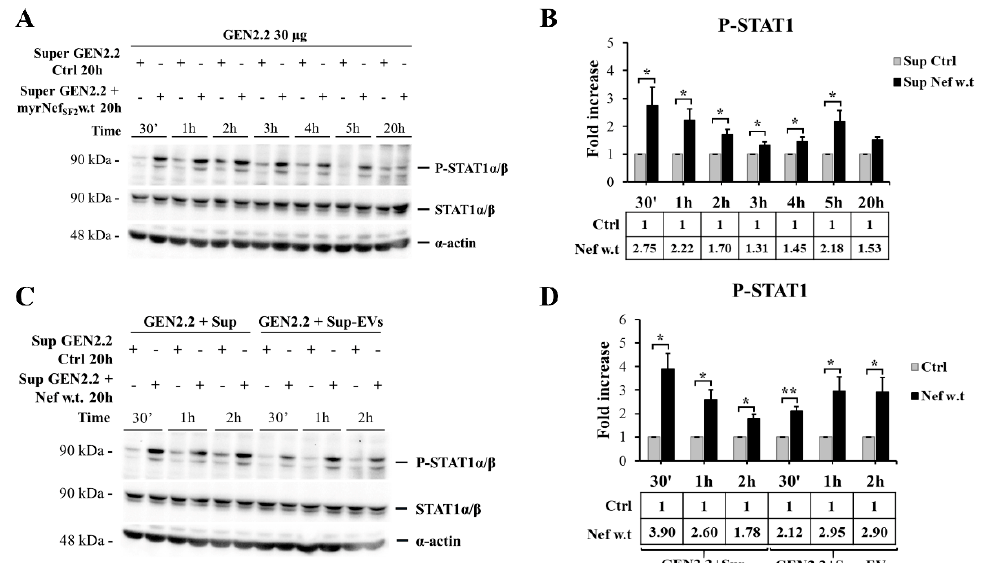
Figure 8. Supernatants from Nef-treated GEN2.2 cells depleted or not depleted of EVs activate STAT1 tyrosine phosphorylation of GEN2.2 cells early. GEN2.2 cells were seeded at 1 × 10 6 cells/mL in 75 cm 2 flask in 12 mL of final volume and left untreated or treated with 300 ng/mL of myrNef SF2 w.t. After 20 h, supernatants from control and treated GEN2.2 cells were harvested and depleted or not depleted of EVs by ultracentrifugation. Complete supernatants ( A ) and supernatants depleted of EVs ( C ) were used to treat fresh GEN2.2 cells for the indicated time points. ( A , C ) Cell lysates (30 µg) were analysed on 9% SDS-PAGE gel, and the immunoblotting was performed using a phospho-Tyr (701)-STAT1 specific antibody. ( B , D ) Densitometric analyses of three independent Western blotting experiments are shown. The band density ratio of P-STAT1 normalized to relative actin is reported in the histograms. P-STAT1/actin ratio in control cells (Ctrl) was set to 1. Fold increases after the addition of the indicated treatments were calculated and reported as means ± S.D. One-way ANOVA test; *, p < 0.05; **, p < 0.01; vs. respective Ctrl.